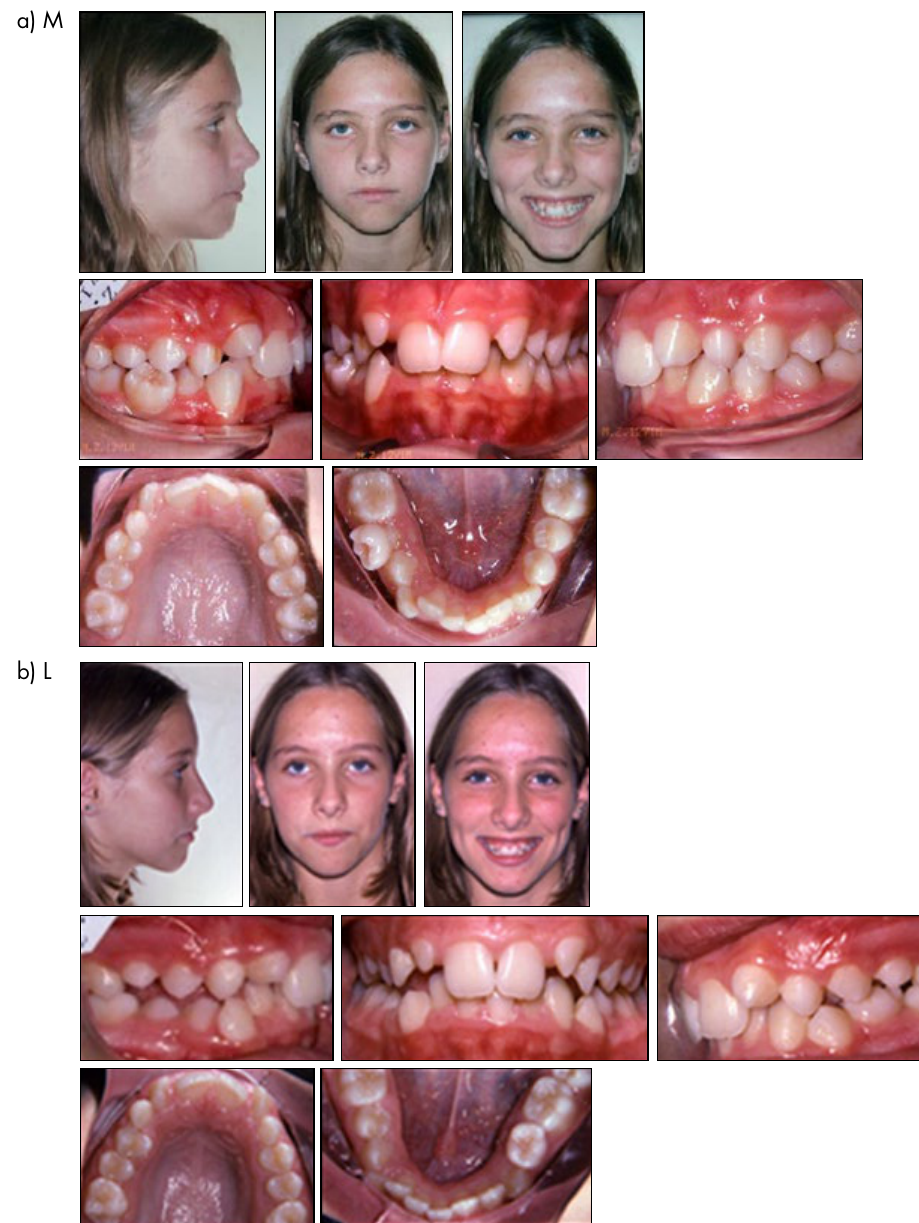
Figure 1. Pretreatment facial and intraoral